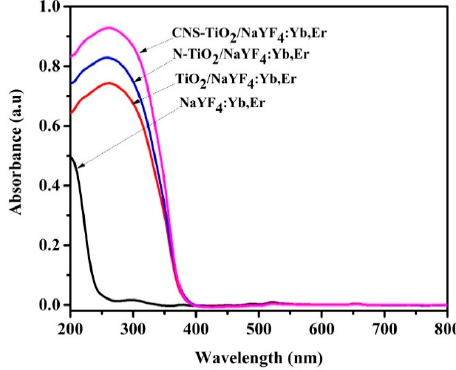
Figure 4. UV-Vis absorption spectra of NaYF 4 :Yb,Er coated with TiO 2 , N-TiO 2 , and CNS-TiO 2 .